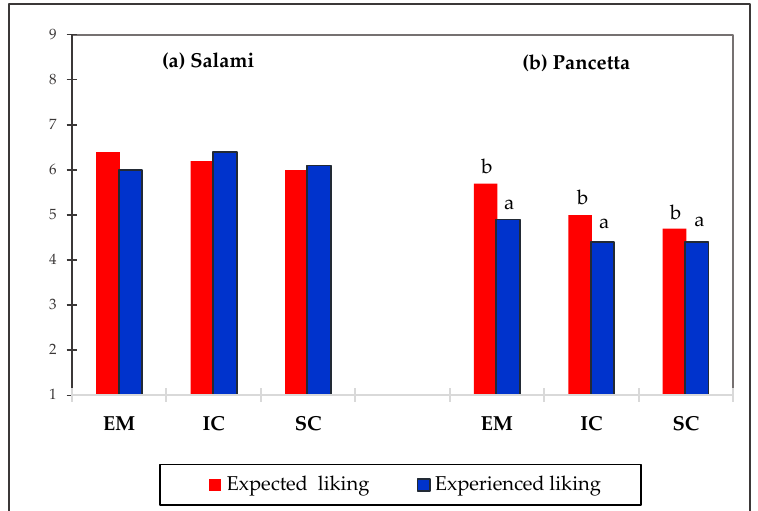
Figure 5. Comparison of the expected and experienced liking of the EM, IC and SC salami (a) and pancetta (b).